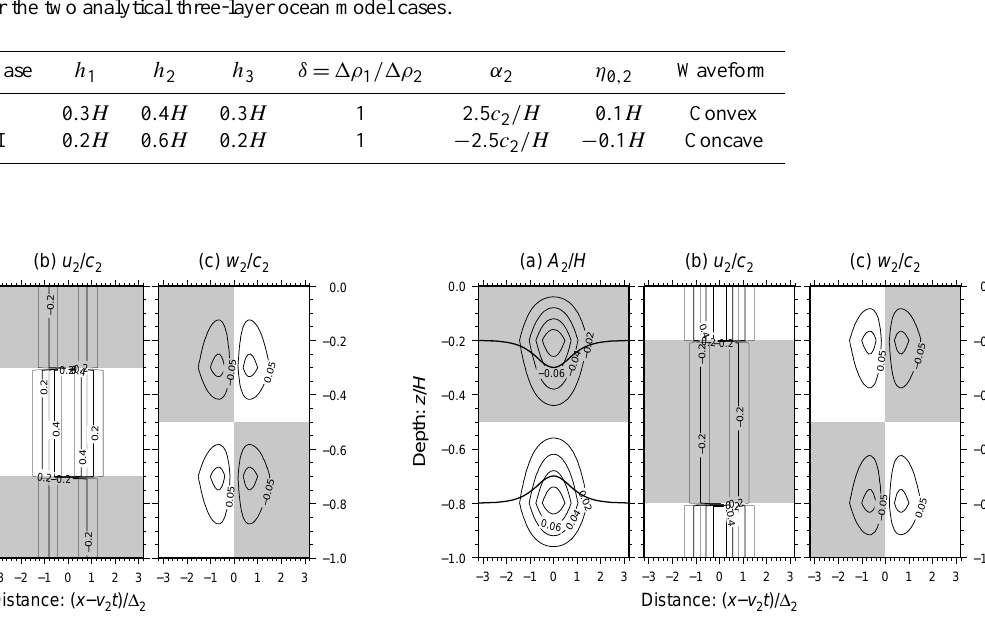
Table 1. The parameters for the two analytical three-layer ocean model cases.